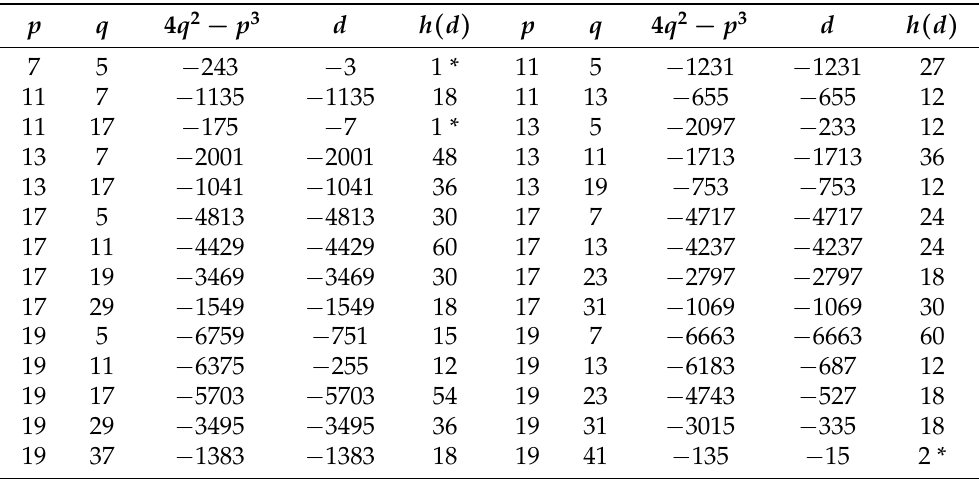
Table 1. Numerical examples for n =